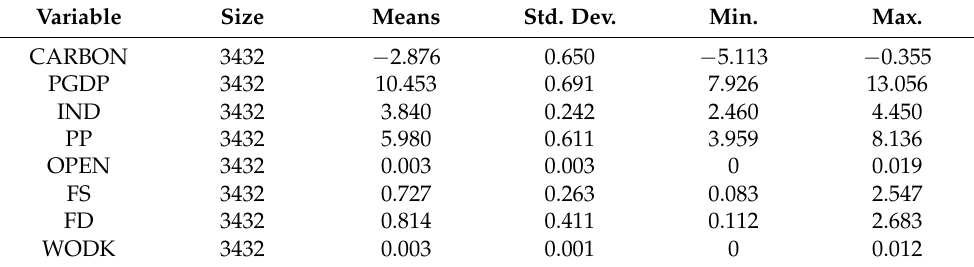
Table 3. Descriptive